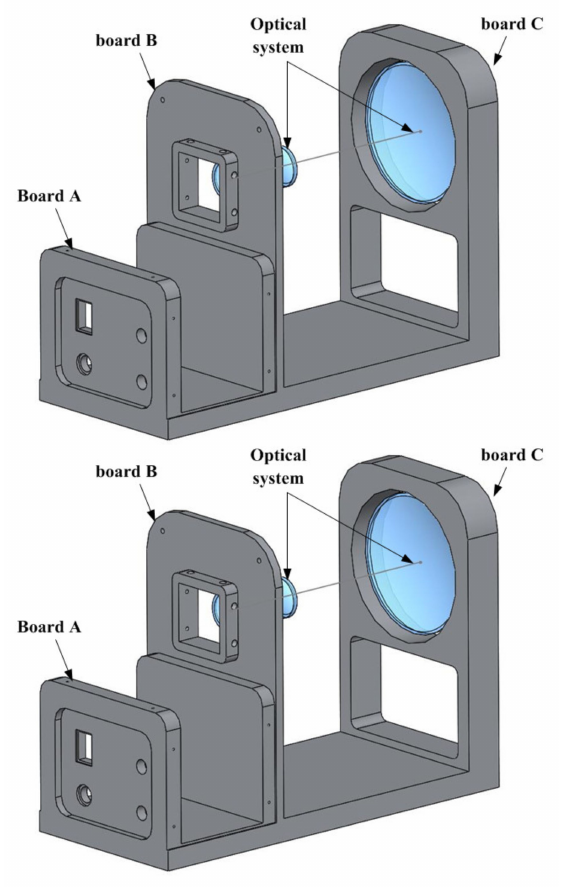
Figure 12. The structure of optical image stabilization system.